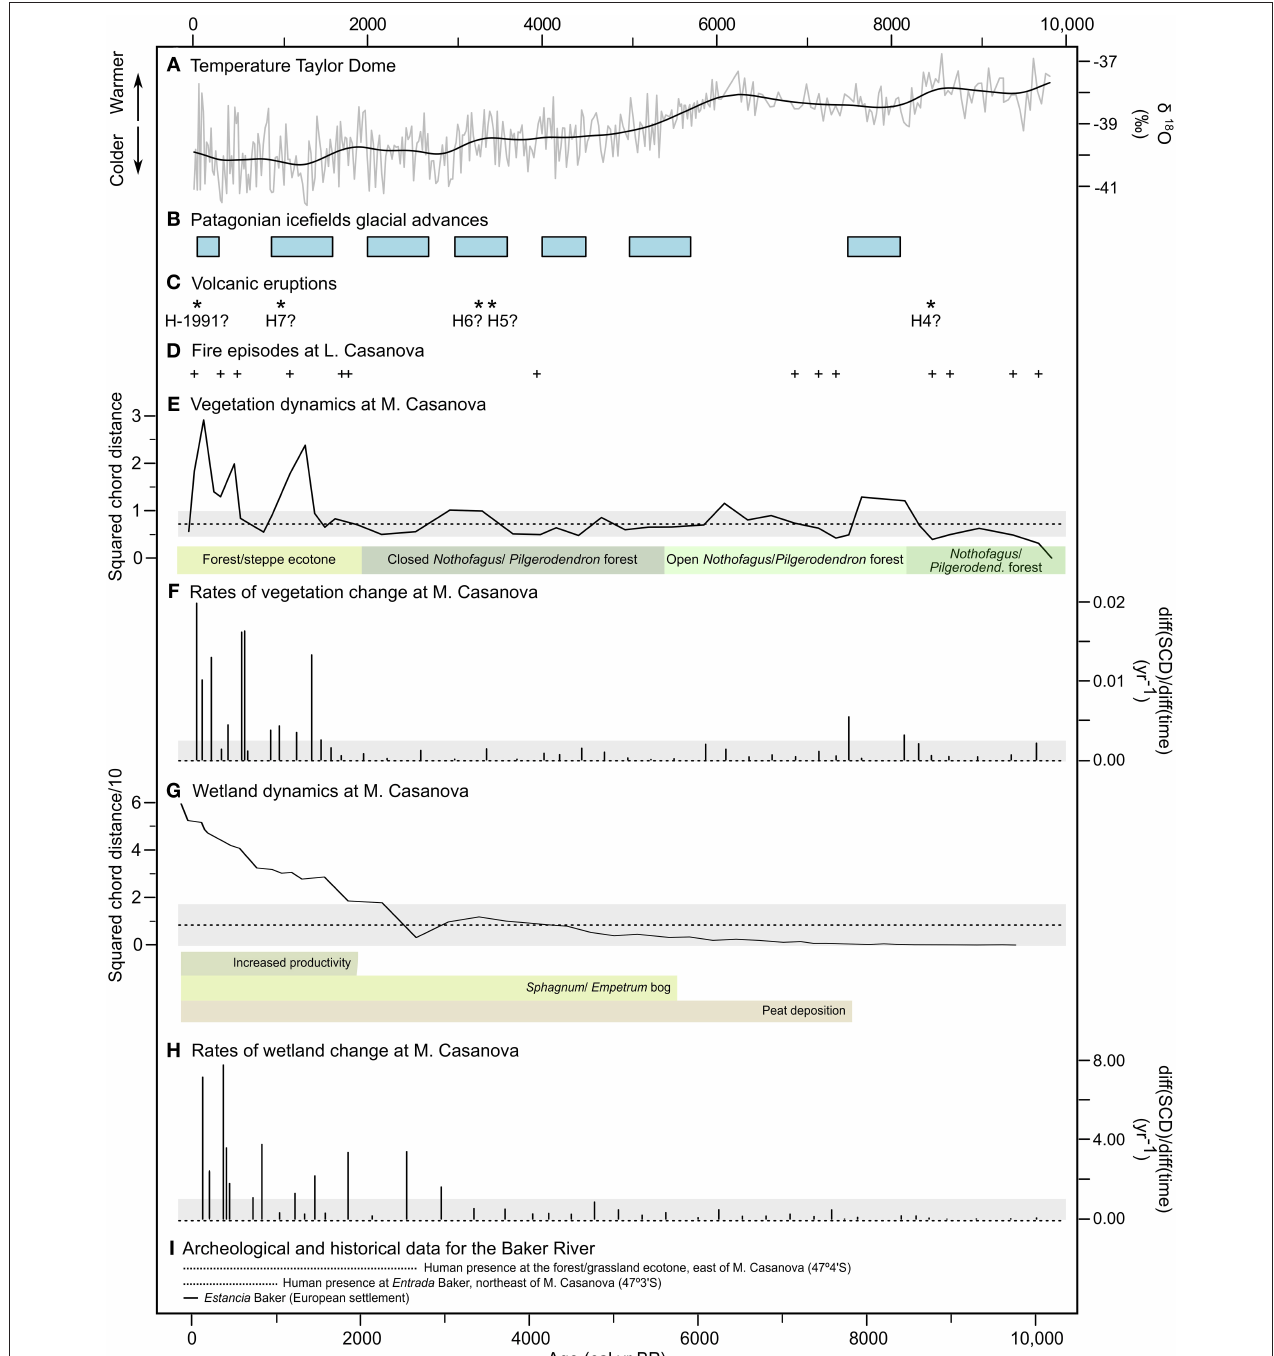
FIGURE 4 | (A) δ 18 O record from Taylor Dome (Grootes et al., 1993). (B) Holocene glacial advances of the Patagonian icefields (Aniya, 2013). (C) Possible events of tephra deposition associated with known eruptions of the Hudson volcano. (D) Reconstructed fire episodes from M. Casanova charcoal data. Long-term dynamics in (E) vegetation and (G) wetland composition as inferred from the squared chord distance (SCD) between every pollen sample and the first sample of the record. The median Holocene SCDs (dashed line) and their confidence intervals (gray shading) are shown. Pollen zones and wetland characteristics (as interpreted from changes in lithology, sedimentation rates, magnetic susceptibility, and the presence/absence of Sphagnum spores) are indicated. Estimated rates of change in (F) vegetation and (H) wetland composition inferred from pollen data. Confidence intervals for 0 yr − 1 (i.e., no change) are depicted in gray. (I) Archeological and historical information for the study area (Martinic, 1977; Mena and Jackson, 1991; Fuentes-Mucherl et al., 2012).